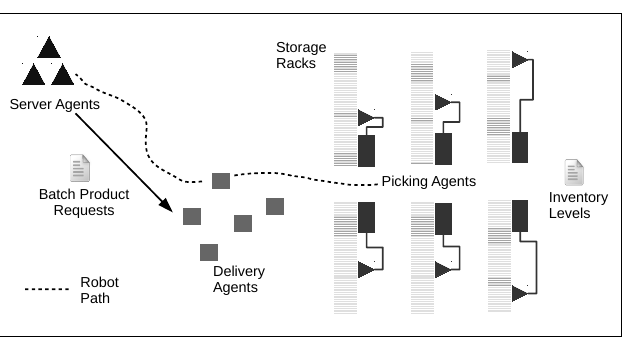
Figure 2. Multiple Agents deployed in